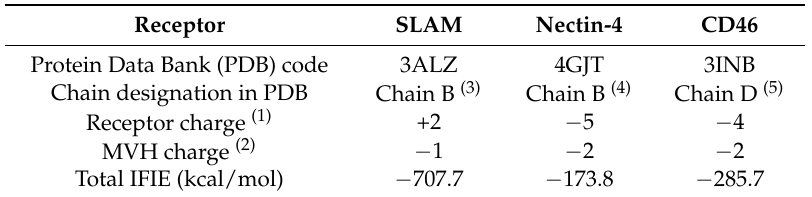
Table 1. Total IFIEs (IFIE sums) in complexes between MVH and three types of receptors, SLAM, Nectin-4, and